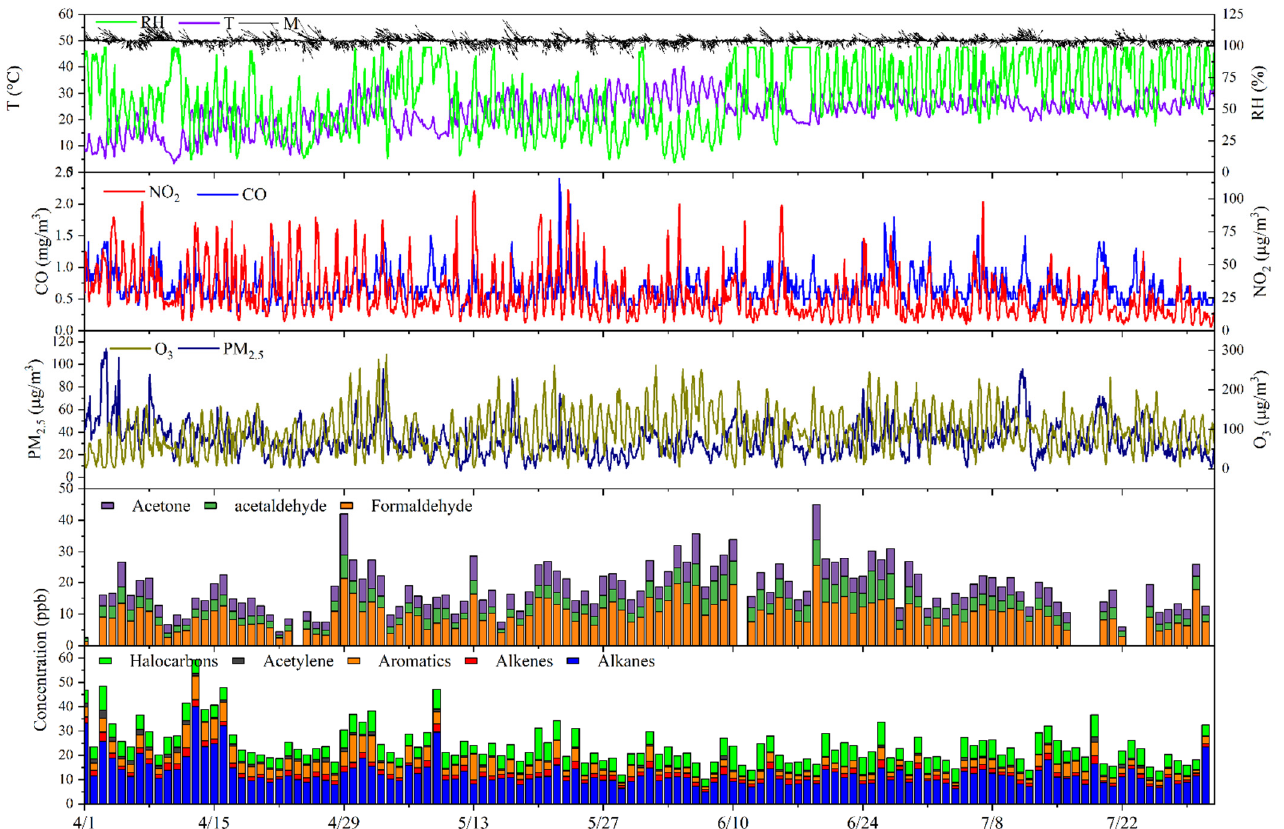
Figure 2. Time series of pollutants (VOCs, O 3 , PM 2.5 , NO 2 , CO) and meteorological parameters (WD, WS, T, RH) during the observation periods. Table 1. Concentrations of VOCs and major VOC groups in Xinxiang and other cities from this study and previous studies (in